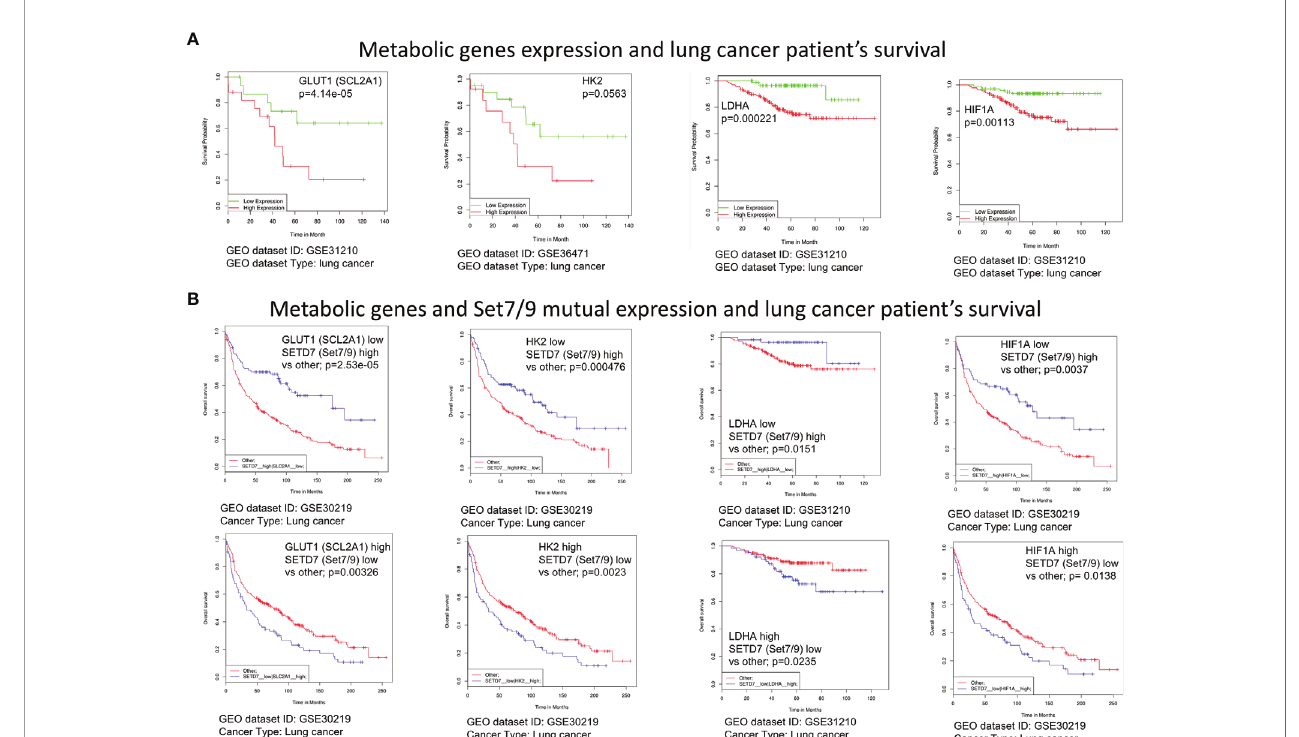
FIGURE 6 | The expression level of Set7/9, HIF1A, GLUT1, HK2, and LDHA affects survival rate of lung cancer patients. (A) The bioinformatic analysis of the association of GLUT1 (SCL2A1), LDHA, HK2, and HIF1A expression levels with NSCLC patients ’ survival. (B) The bioinformatic analysis of the GLUT1 (SCL2A1), LDHA, HK2, and HIF1A and Set7/9 (SETD7) mutual expression effect on NSCLC patients ’